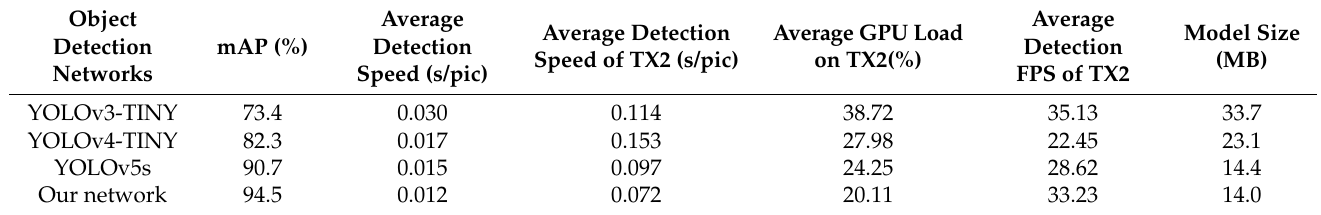
Table 2. Comparison of different detection models in the Zanthoxylum pepper